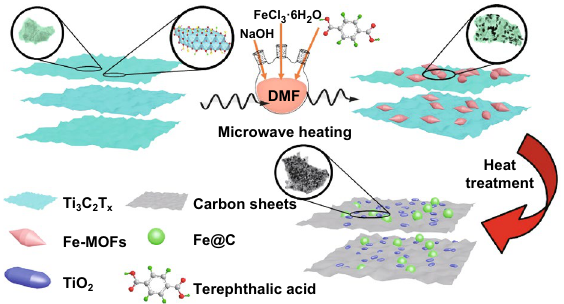
Fig. 1 Schematic representation of the facile synthesis route of the Fe&TiO